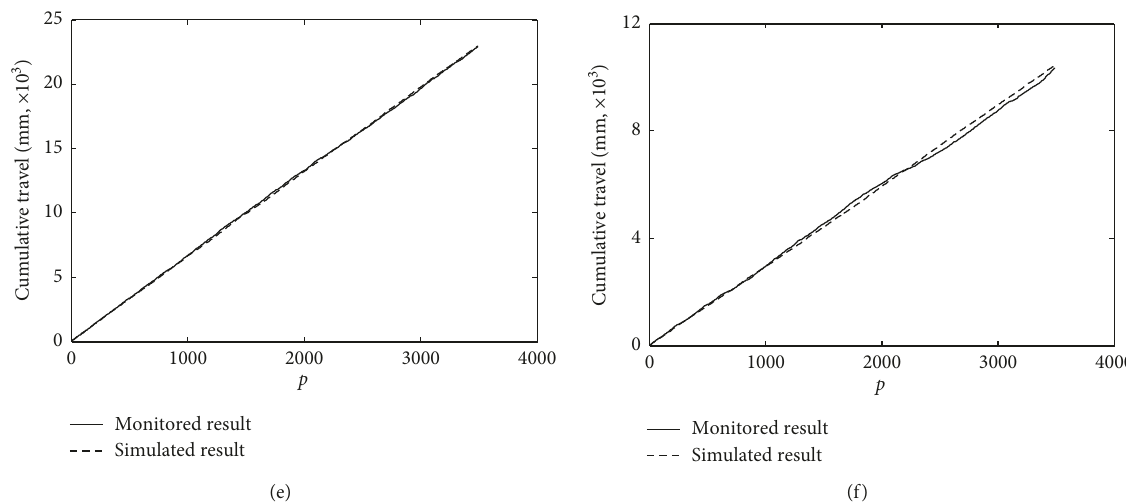
Figure 12: The simulated M (f) M